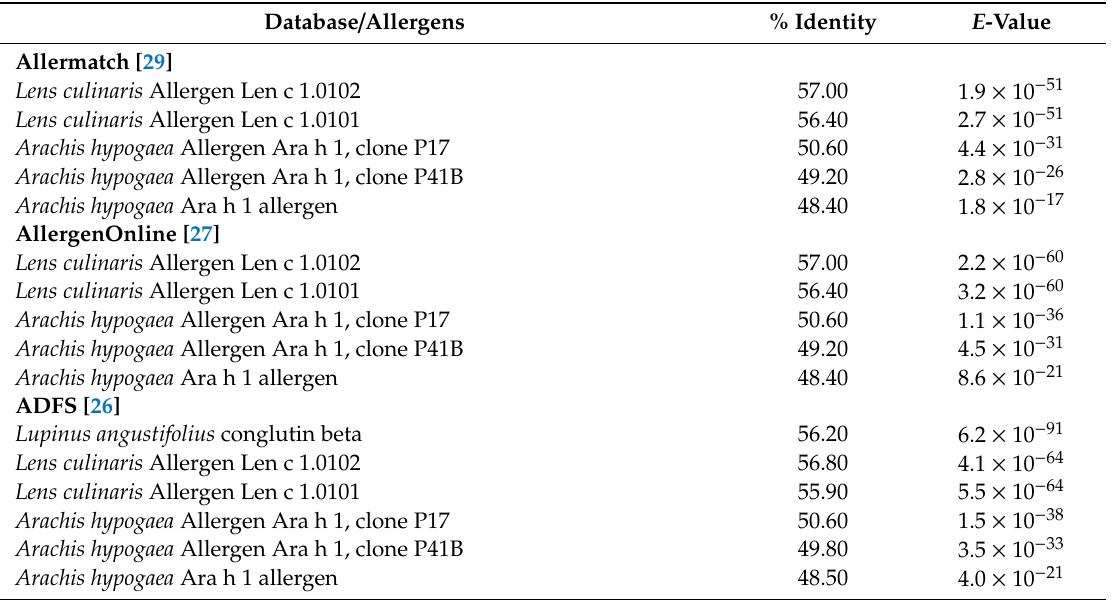
Table 7. Analysis of the allergenic potential of Mut2 8S α globulin using full-length FASTA